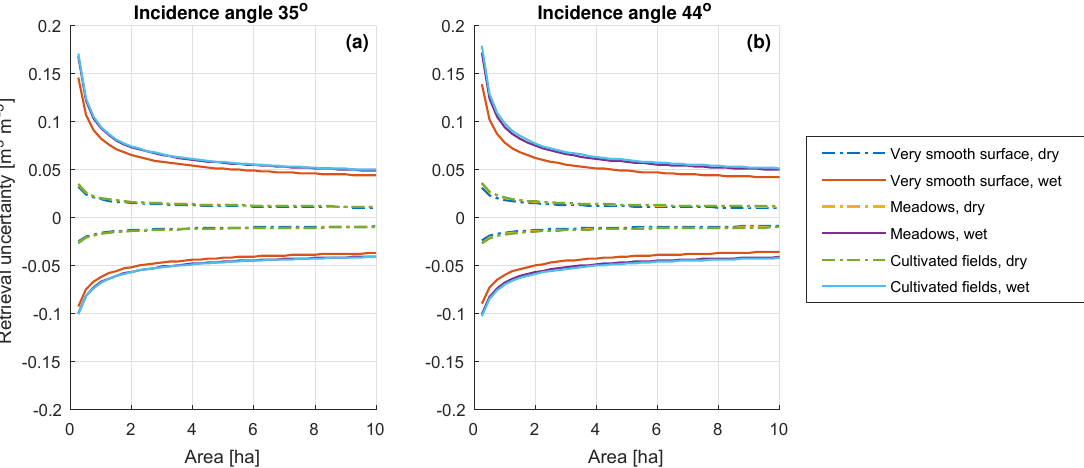
Figure 12. Upper ( ∆ θ + ) and lower boundary ( ∆ θ − ) of the soil moisture retrieval uncertainty due to the s S 1 at VV polarization as a function of A , for incidence angles of 35 ◦ ( a ) and 44 ◦ ( b ), for the three surface roughness scenarios (Table 3) and for dry soil (soil moisture equal to 0.10m 3 m −3 ) and wet soil (soil moisture equal to 0.35m 3 m −3